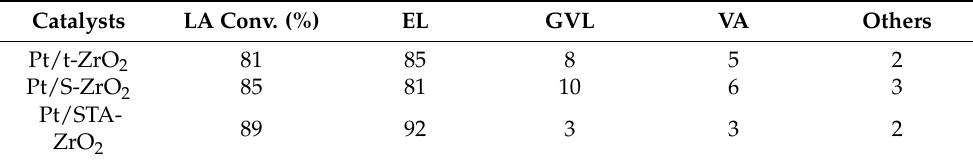
Table 2. Effect of zirconia oxide phases of Pt catalysts over LA esterification.